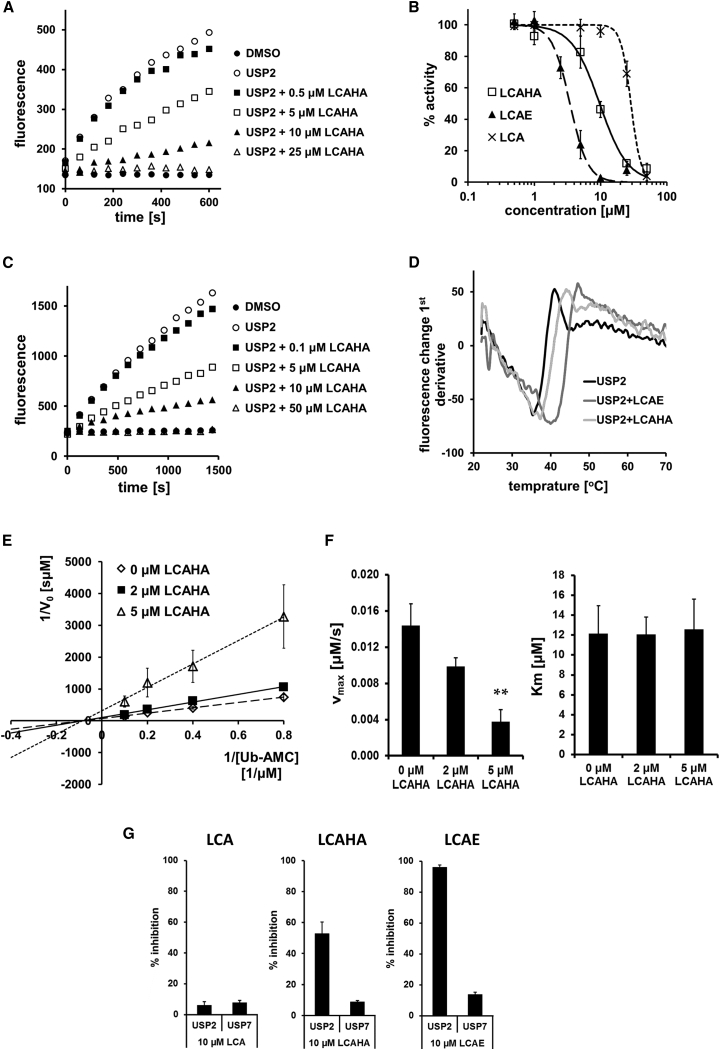
Effect of Selected Compounds on USP2a Activity(A) Ub-AMC hydrolysis assay demonstrates that LCAHA inhibits USP2a enzymatic activity. USP2a catalytic domain was incubated with the substrate and increasing concentrations of LCAHA and the fluorescence signal were measured during the time course of the experiment. The graph shows representative data of three or more repeats. See also Figure S5.(B) Dose-response inhibition of USP2a activity measured in the Ub-AMC hydrolysis assay in the presence of various concentrations of LCA and its derivatives LCAE and LCAHA. The graph shows mean ± SD values from three independent experiments. See also Figure S5.(C) Di-Ub K63-2 hydrolysis assay demonstrates that LCAHA inhibits USP2a capability to hydrolyze the isopeptide bond between two ubiquitin molecules. The graph shows representative data of three or more repeats.(D) LCA derivatives induce thermal stabilization of USP2a, as monitored by thermal shift assay. The graph presents the effect on USP2a thermal stabilization in the presence of 50 μM LCAE or LCAHA.(E) Kinetic analysis of the USP2a-catalyzed hydrolysis of Ub-AMC substrate in the presence of the LCAHA. The reciprocal initial velocities are plotted versus the reciprocal substrate concentrations (Lineweaver-Burk plot). The graphs show mean ± SD values from three independent experiments.(F) Vmax and Km values determined by fitting the Lineweaver-Burk equation. Kinetic constants trends are characteristic for the non-competitive inhibition model. The graphs show mean ± SD values from three independent experiments. Statistical significance was evaluated using one-way ANOVA with Tukey's post hoc test: **p < 0.01. See also Table S1.(G) The inhibition of USP2a and USP7 enzymes by the LCA, LCAE, and LCAHA compounds in the Ub-AMC assay. The graphs present percent inhibition of the proteins' activity in the presence of compounds at 10 μM and show mean ± SD values from three independent experiments. See also Figure S5.